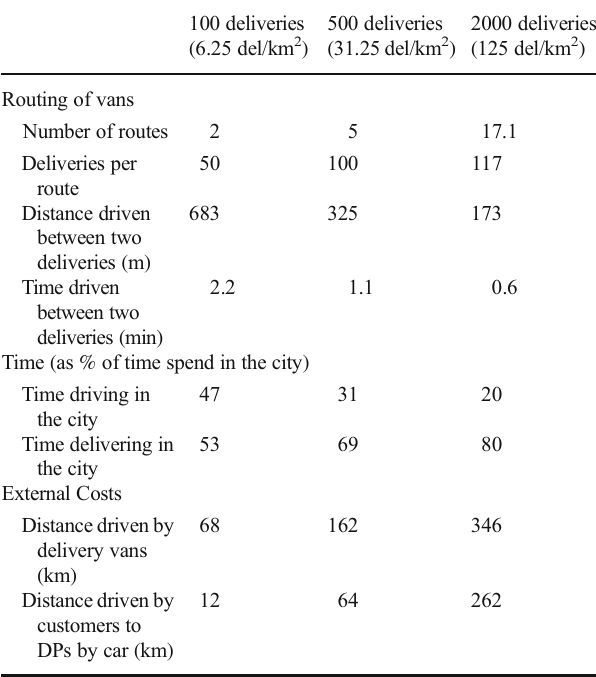
Results from the simulation of van deliveries for different demand densities